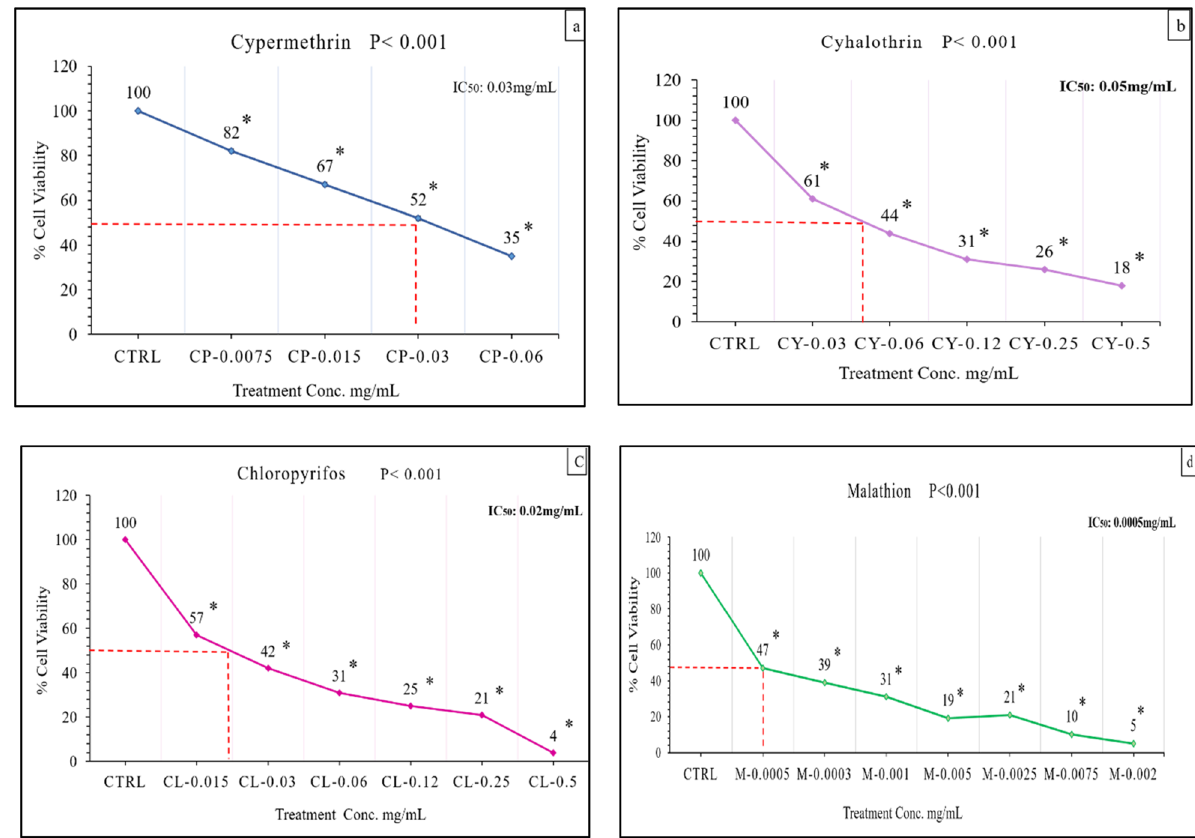
Figure 2. Mean cell viability of NIH 3T3 cells after 24 h on exposure to different specific concentrations of PYR pesticide in mg/mL. (a) Cypermethrin (PYR) ( b) Cyhalothrin (PYR) (c) Chloropyrifos (OPs) ( d) Malathion (OPs). ANOVA and LSD post-hoc analyses were used to compare means of the treated cells with untreated control cells. Data were presented as Standard Error of Mean (Mean ± SEM) of triplicate determinations. The mean difference is significant when * p < 0.001. n= 4, CTRL: Control, CP: Cypermethrin, Cy: Cyhalothrin; Cl: Chloropyrifos, M: Malathion; IC50: maximum half inhibitory concentration (mg/mL).